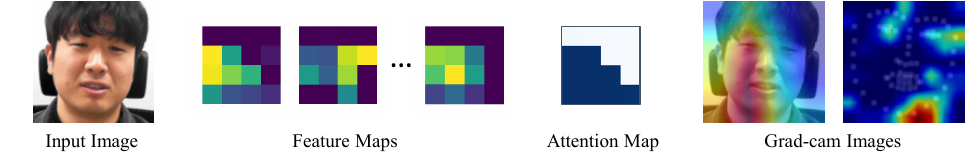
Figure 7. Feature maps, attention map, and Grad-cam images output from an example facial